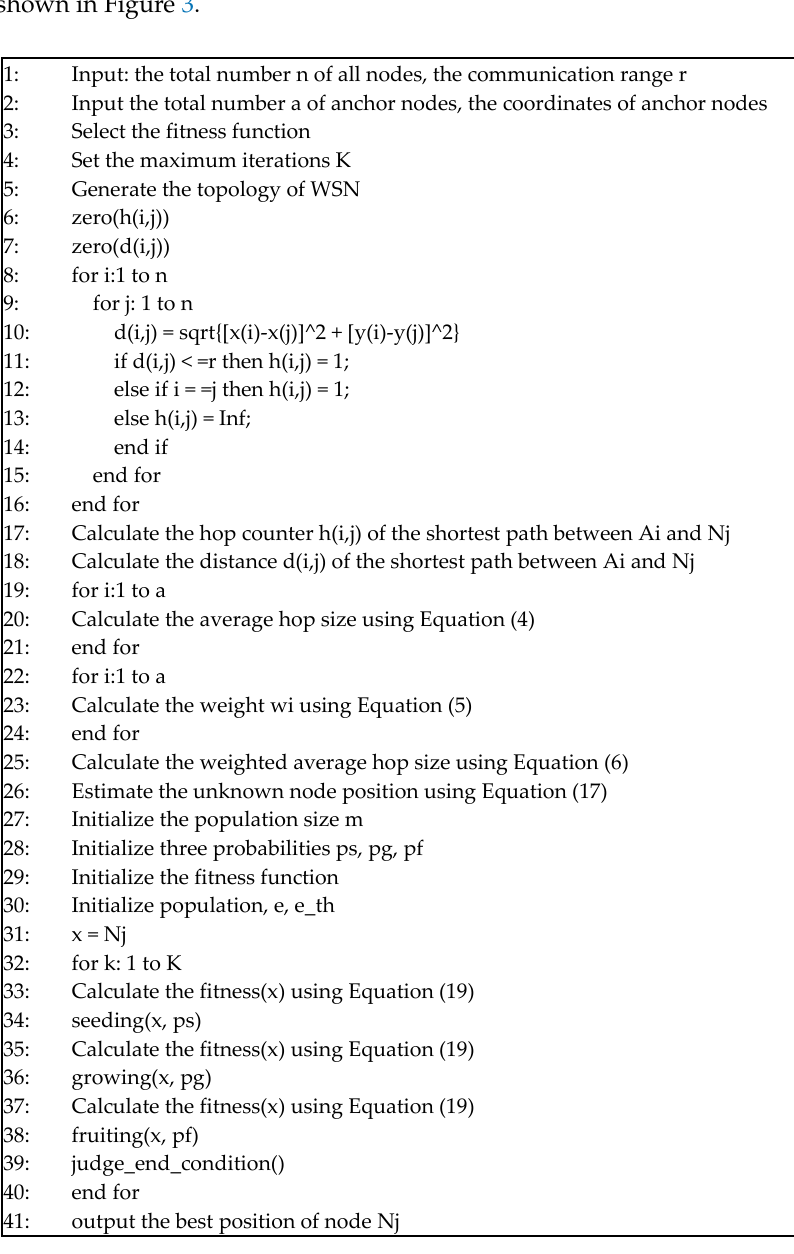
Figure 3. The pseudo-code of APC.